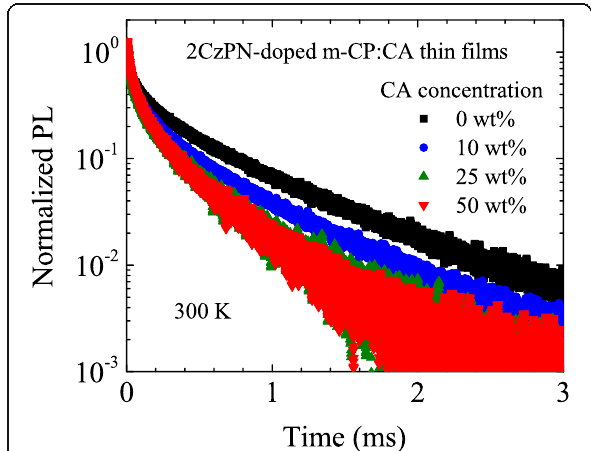
Fig. 6 PL decay curves measured at 300 K for 2CzPN-doped m-CP:CA thin films with several CA concentrations